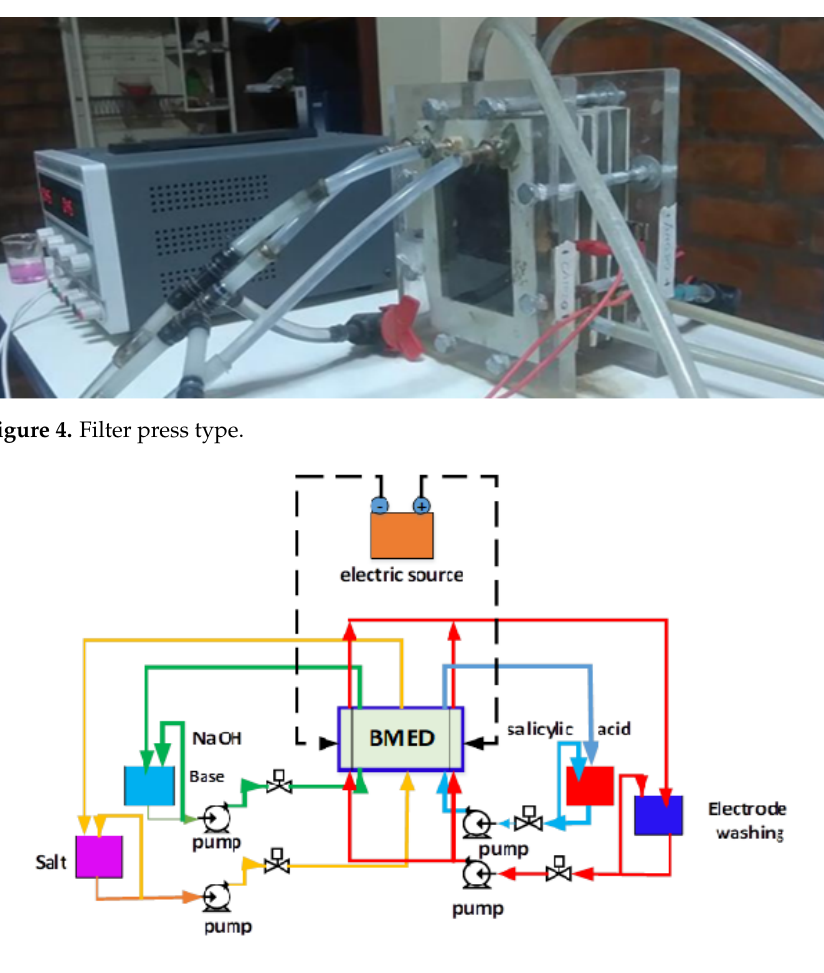
Figure 5. Electrodialysis cell with bipolar